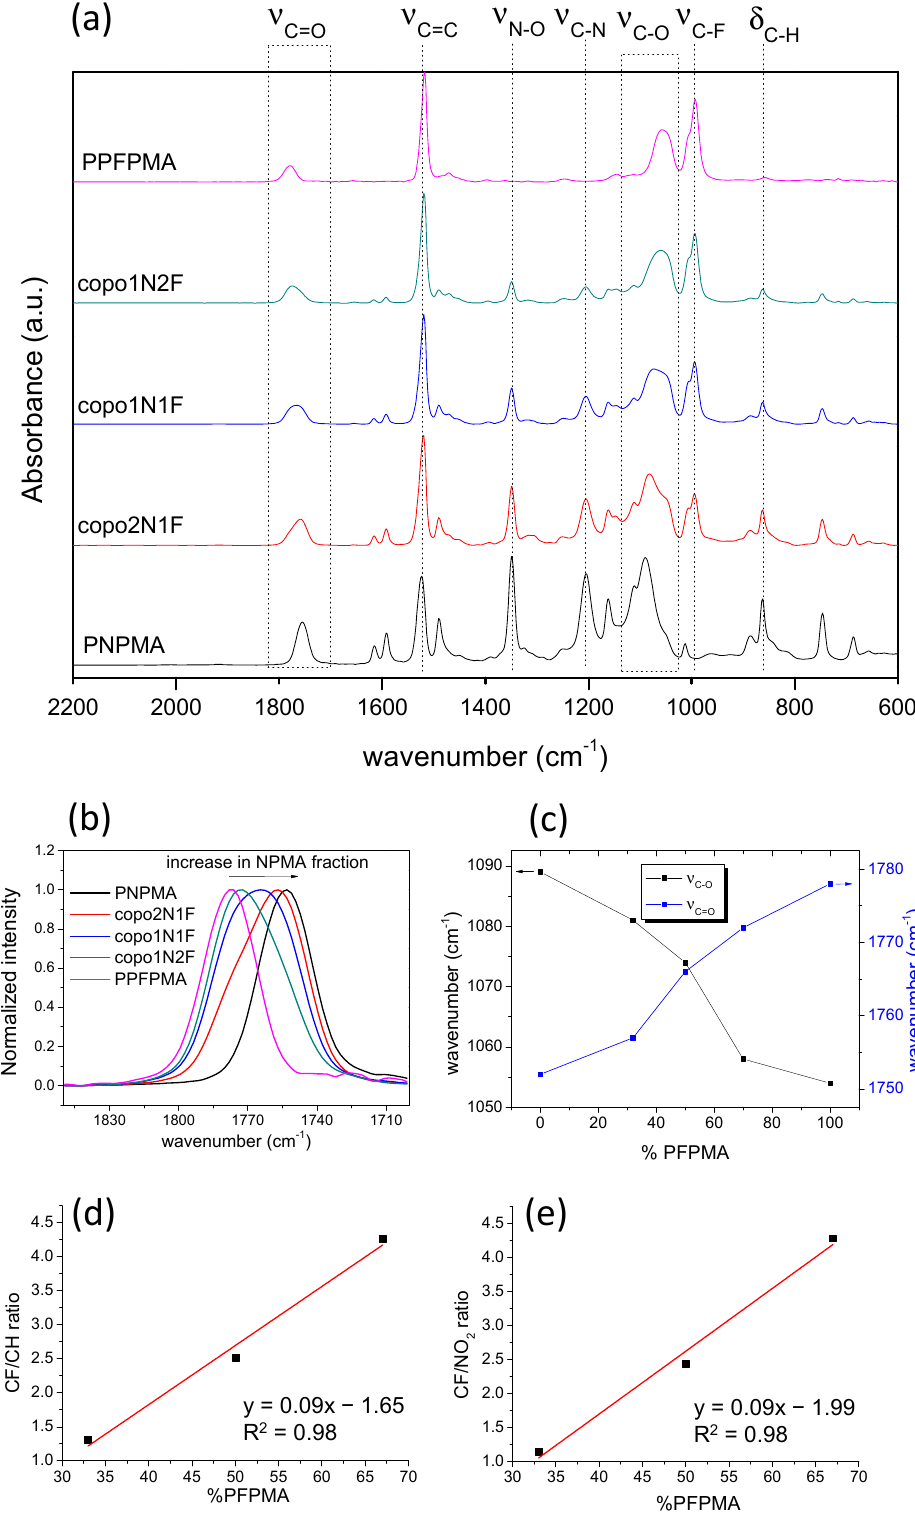
Figure 2. ( a ) ATR-FTIR spectra of homopolymers and their respective copolymers at different compositions, ( b ) enlargement of peaks characterized for C=O vibration, ( c ) maxima of C=O (blue) and C-O (black) peaks related to molar percentage of PFPMA, ( d ) C-F and C-H peak areas ratio depending on the proportion of PFPMA, ( e ) C-F and NO 2 peak areas ratio depending on the proportion of PFPMA.